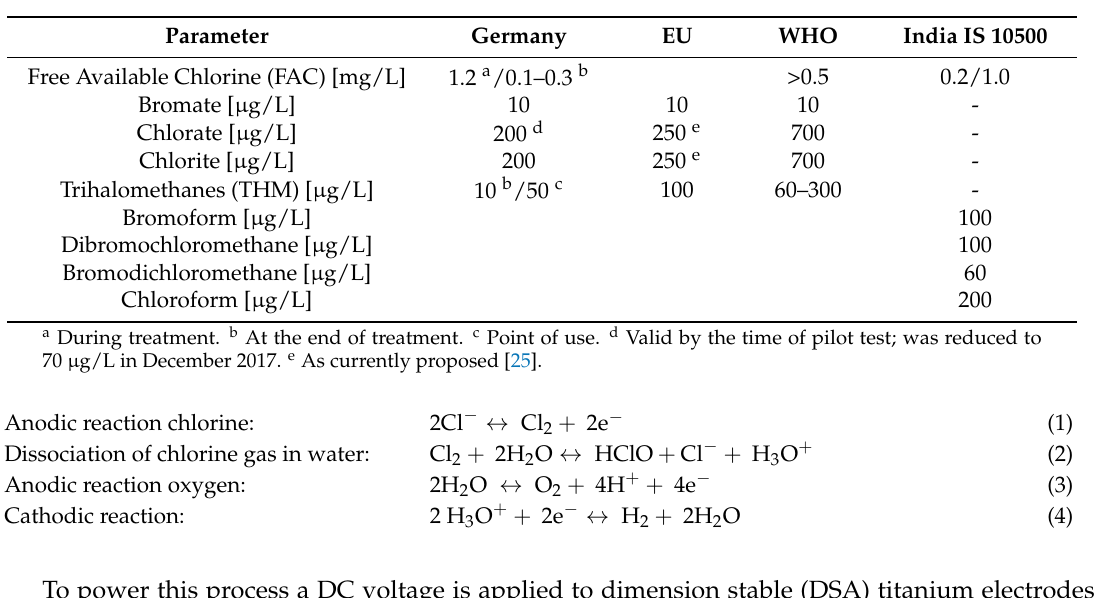
Table 1. Selected guideline values concerning the chlorination of drinking